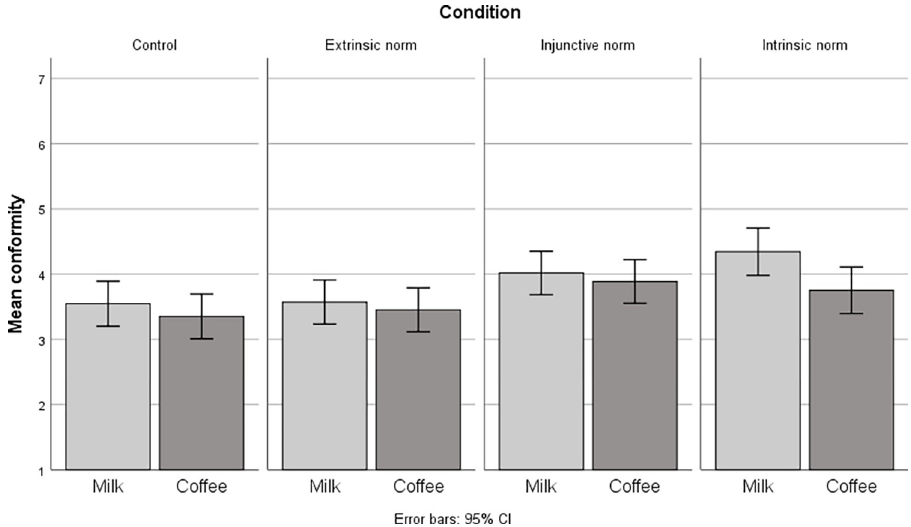
Fig 2. Means with 95% confidence interval for conformity to specific norm (intention to purchase organic milk and coffee products presented separately).